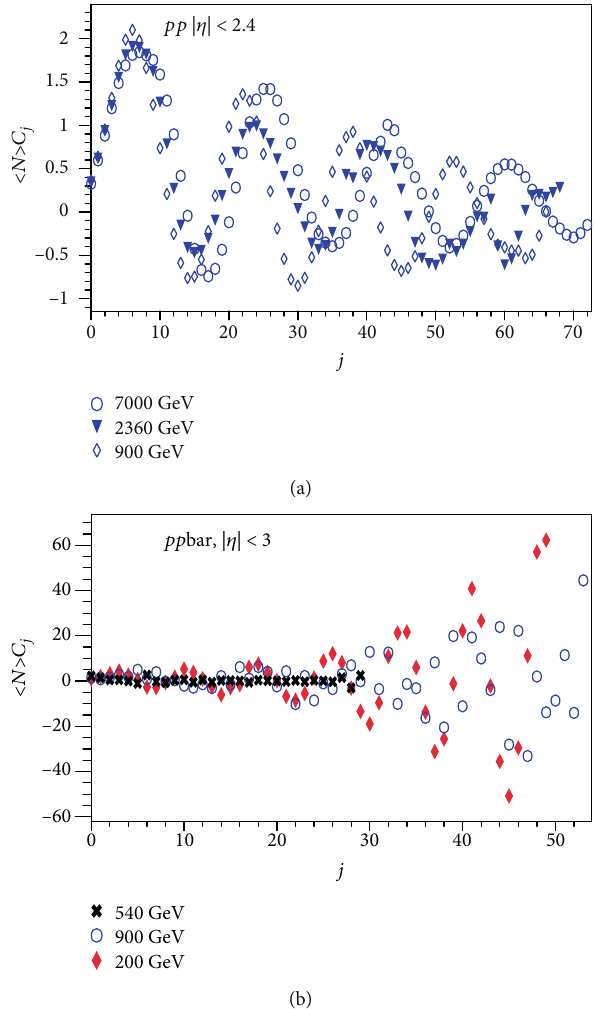
Figure 6: Coe ffi cients C obtained from (i) the CMS data of pp j collisions at di ff erent energies for one pseudorapidity window j η j < 2 : 4 (a) and (ii) the UA5 data of p (cid:1) p collisions at di ff erent energies for pseudorapidity window j η j < 3